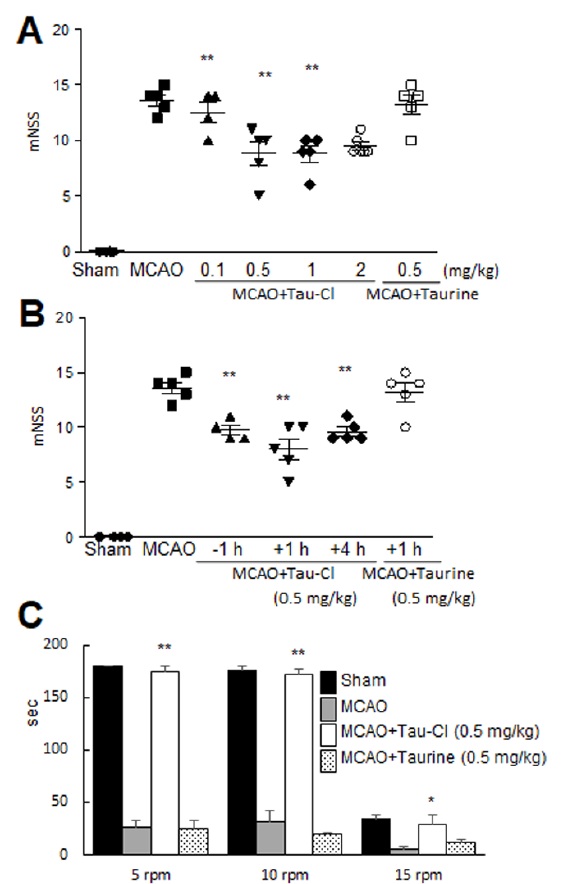
Figure 2. Tau-Cl recovered neurological and motor deficits. ( A , B ) Tau-Cl (0.1, 0.5, 1 or 2 mg/kg) or taurine (0.5 mg/kg) was administered intranasally 1 h post-MCAO ( A ), or Tau-Cl (0.5 mg/kg) was administered intranasally at 1 h prior to or 1 or 4 h post-MCAO ( B ). Neurological deficits were evaluated using modified neurological severity scores at 2 days post-MCAO. ( C ) Tau-Cl (0.5 mg/kg) or taurine (0.5 mg/kg) was administered intranasally 1 h post-MCAO, and the rotarod test was performed 2 days post-MCAO at 5, 10, and 15 rpm at with a 1 h inter-trial rest period. Data are presented as mean ± SEM (n = 3–6). Sham, sham-operated rats (n = 4); MCAO, PBS-treated MCAO controls (n = 10); MCAO + Tau-Cl, Tau-Cl-treated MCAO rats (n = 10); MCAO + Taurine, taurine- treated MCAO rats (n = 8). * p < 0.05, ** p < 0.01 vs. PBS-treated MCAO controls by one-way ANOVA with Student – Newman – Keuls test. Table 1. Physiological parameters.